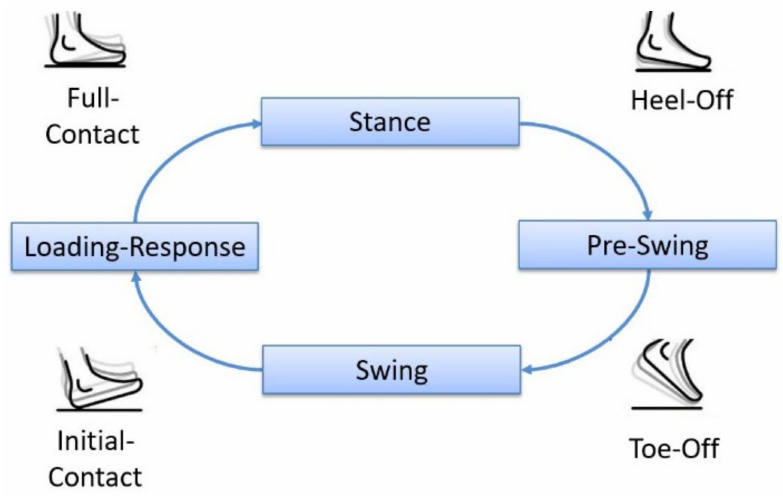
Figure 5. State diagram of gait events, adapted from [19].